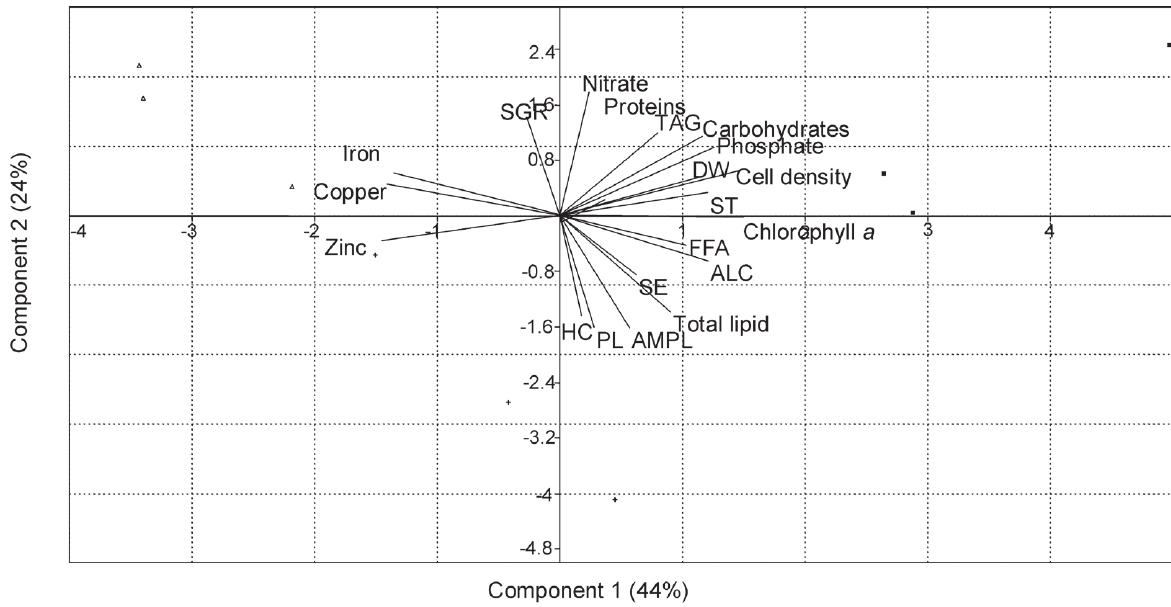
Figure 4 - PCA biplot for the various parameters measured for Chlorella vulgaris cultured with different growth media using semi continuous culture. SGR = specific growth rate and DW = dry